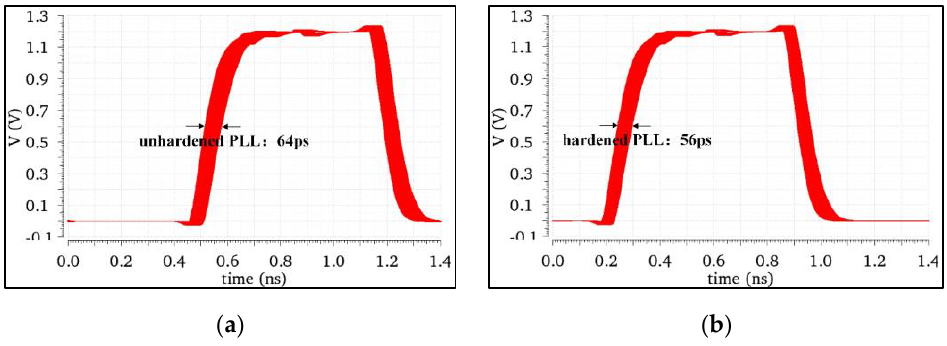
Figure 10. ( a ) Period jitter of the NHPLL. ( b ) Period jitter of the RHPLL.